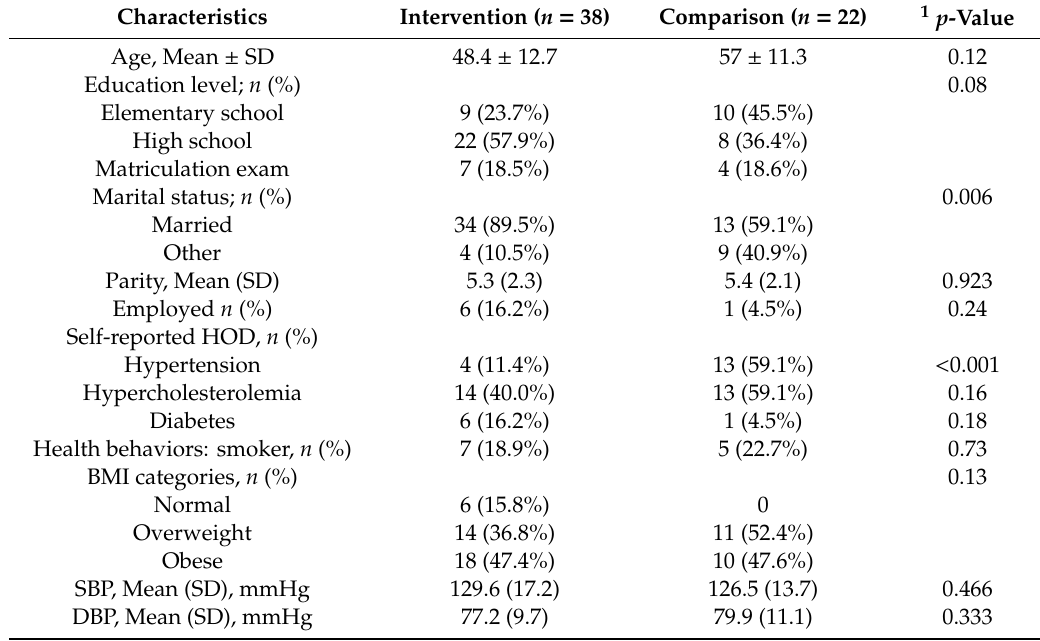
Table 1. Baseline sociodemographic and health characteristics of participants in the quasi-experimental study.